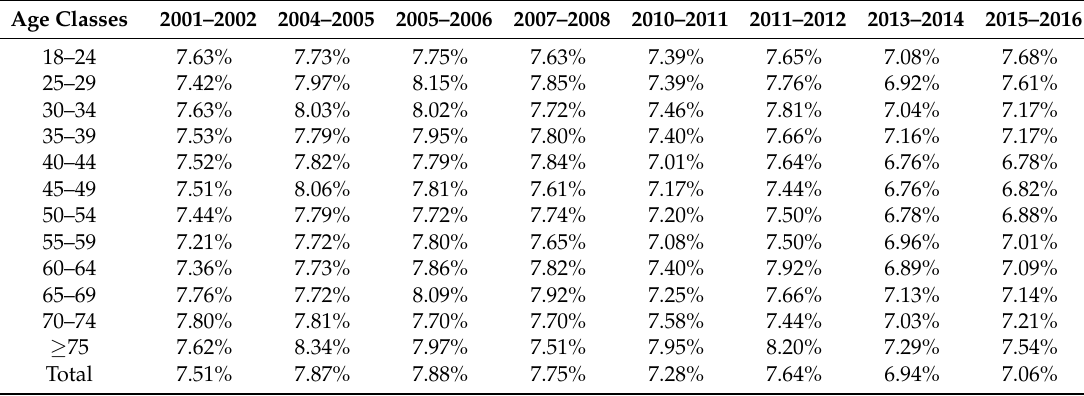
Table 3. Residential Energy Expenditure Share by Household Head’s Age